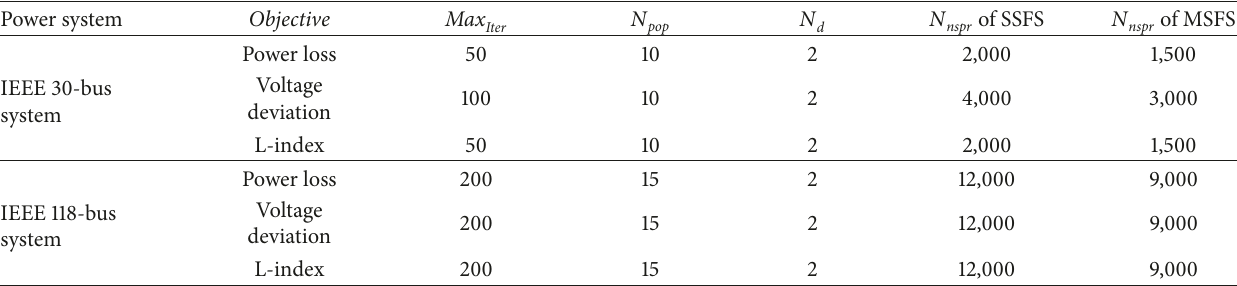
Table 1: The selection of main control parameters for SSFS and the proposed